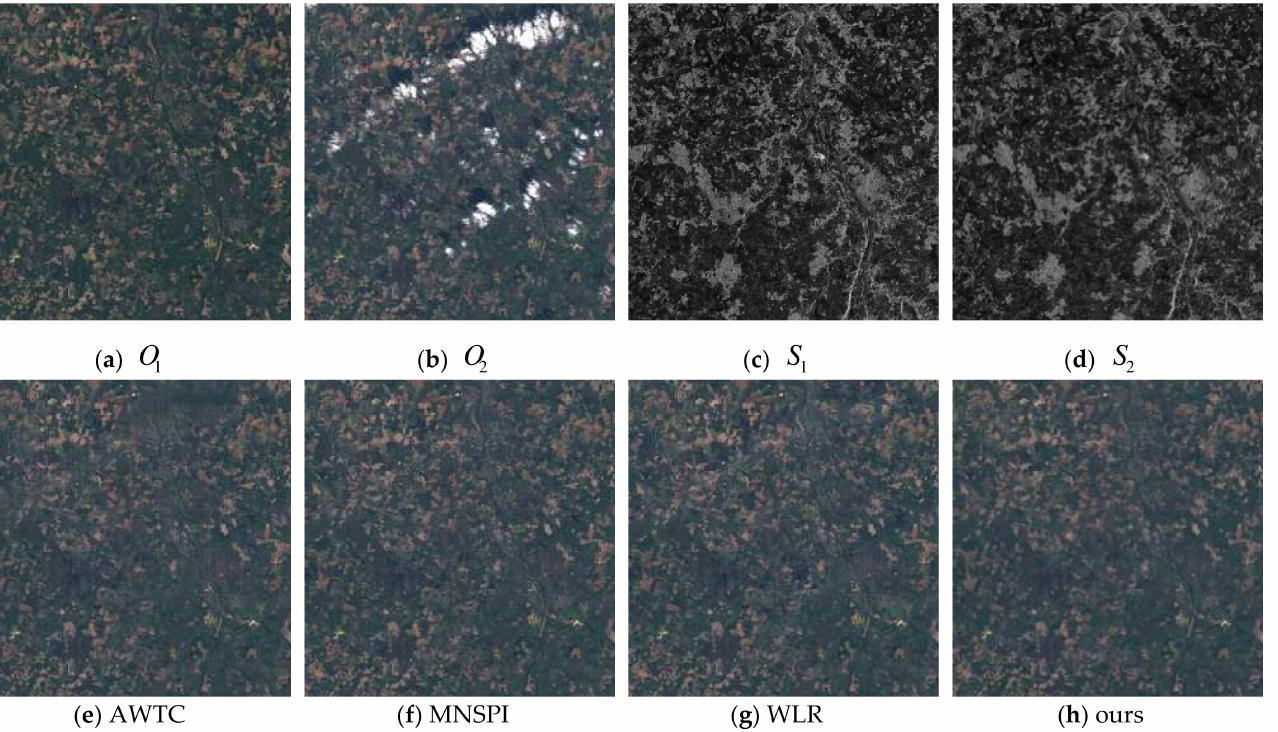
Figure 5. Real experiment results of cloud